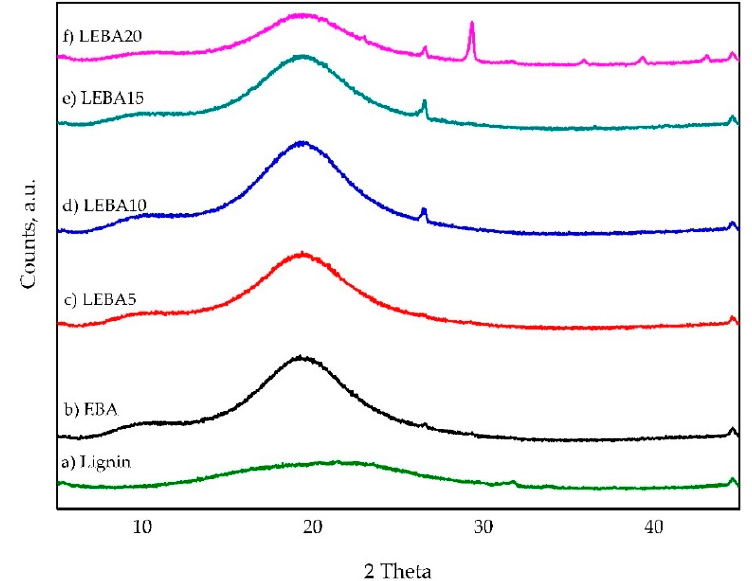
Figure 5. X-ray diffraction patterns for the samples: ( a ) Lignin, ( b ) EBA, ( c ) LEBA5, ( d ) LEBA10, ( e ) LEBA15, and ( f ) LEBA20.